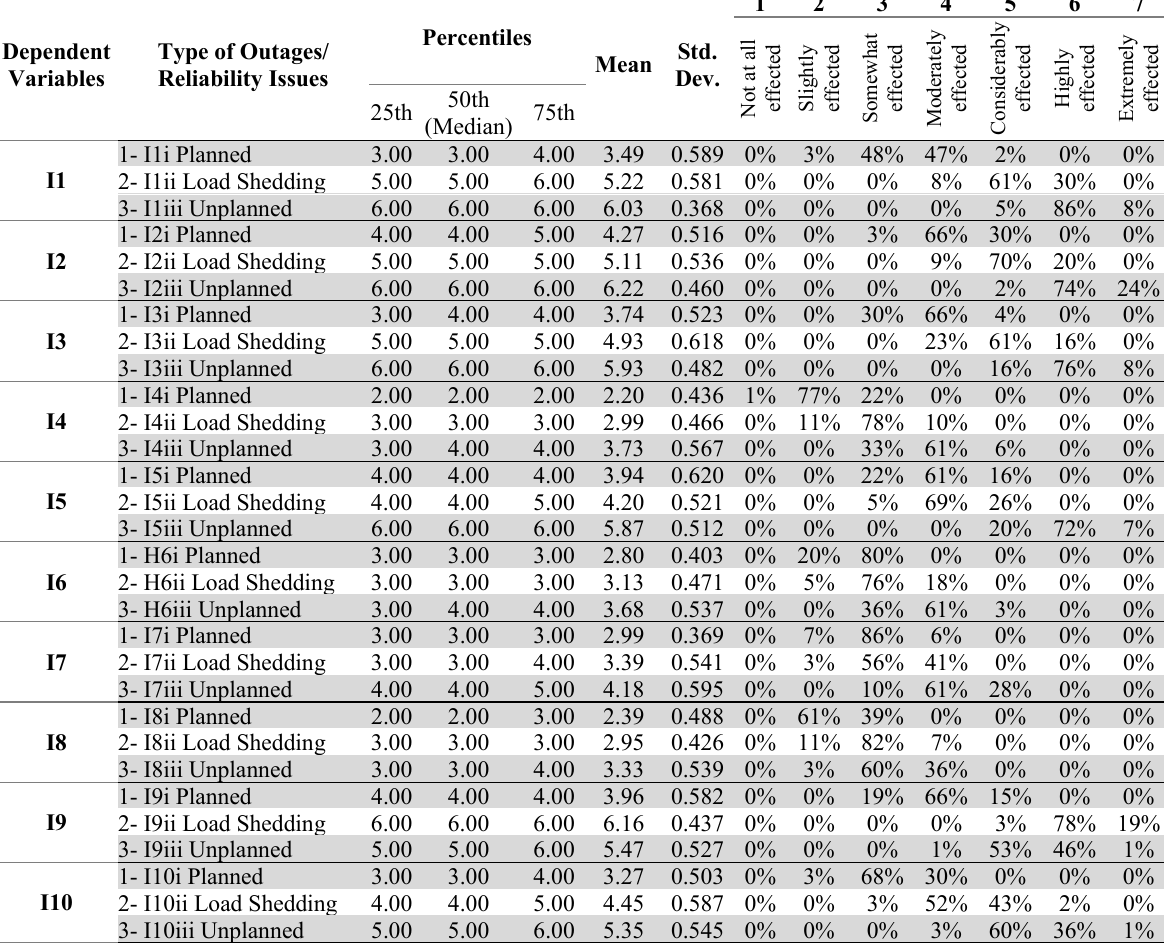
Descriptive statistics- Level of effect by different reliability issues on future plans and strategies Dependent